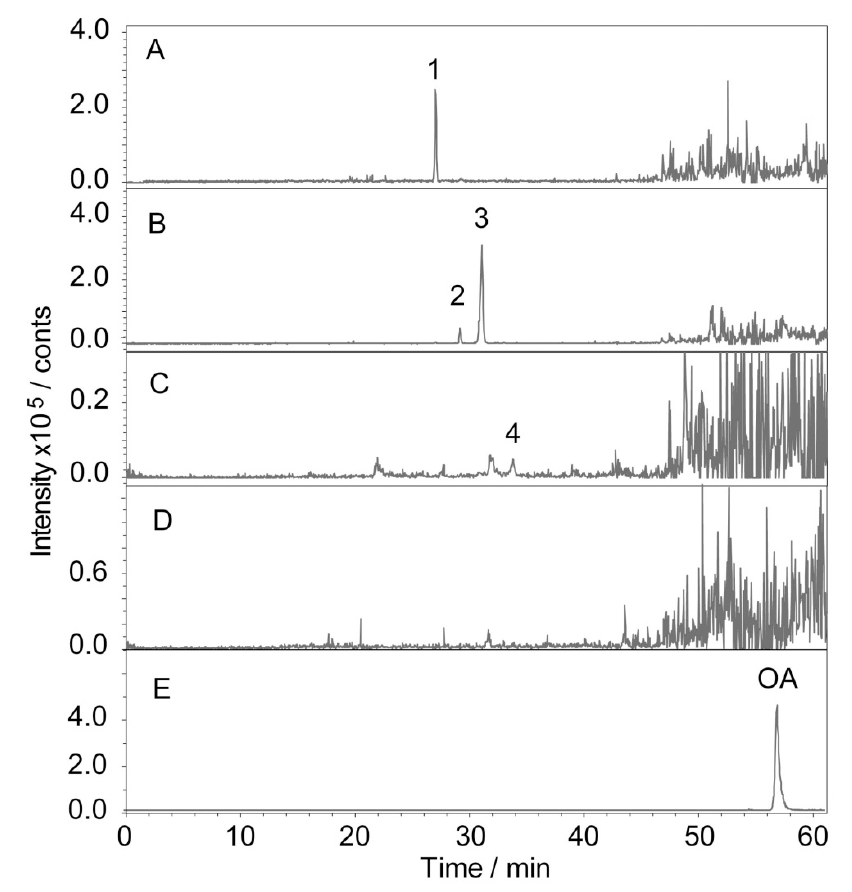
Figure 3. Representative chromatograms of Ro and its metabolites in the plasma. The tumour-bearing mice were administered Ro for 15 successive days, after which they were sacrificed, and the plasma was collected and evaluated. ( A ) Extracted ion chromatogram (EIC) at m / z 955.5; ( B ) EIC at m / z 794.5; ( C ) EIC at m / z 631.5; ( D ) EIC at m / z 455.5; ( E ) chromatogram of standard oleanolic acid (OA) (45.2 ng / inj, EIC at m / z 455.5). (1) Ro: ginsenoside Ro; (2) IVa: chikusetsusaponin IVa; (3) R1: zingibroside R1; (4) E: calenduloside E.